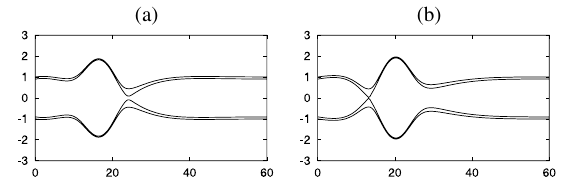
= 0 . 6 at t = 18 . 225 1